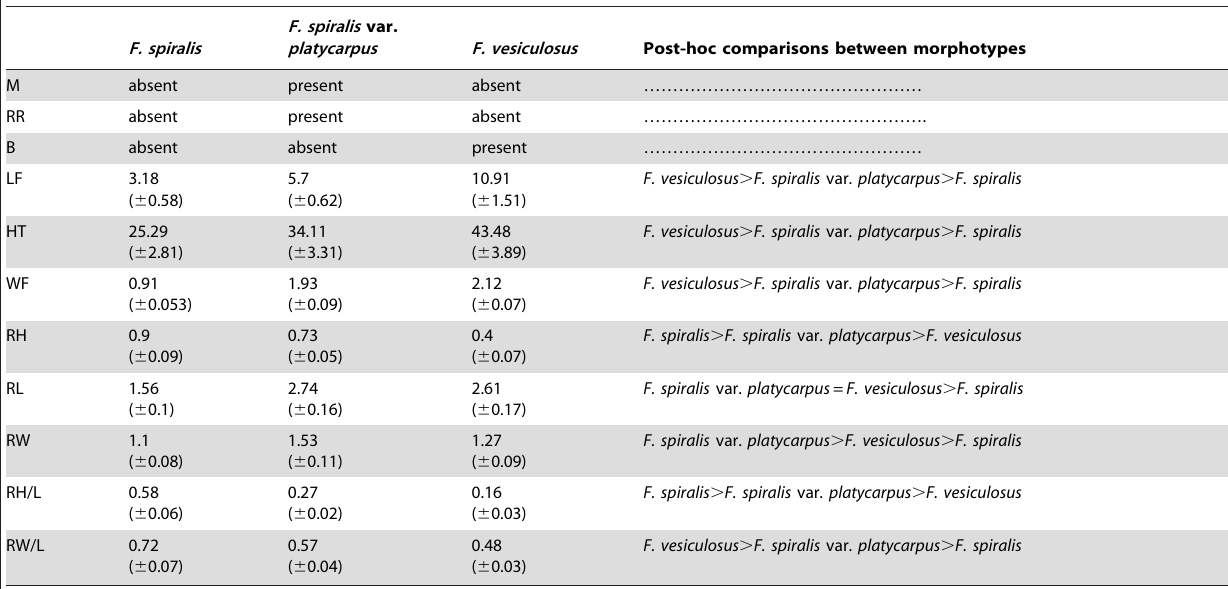
Table 2. Morphological